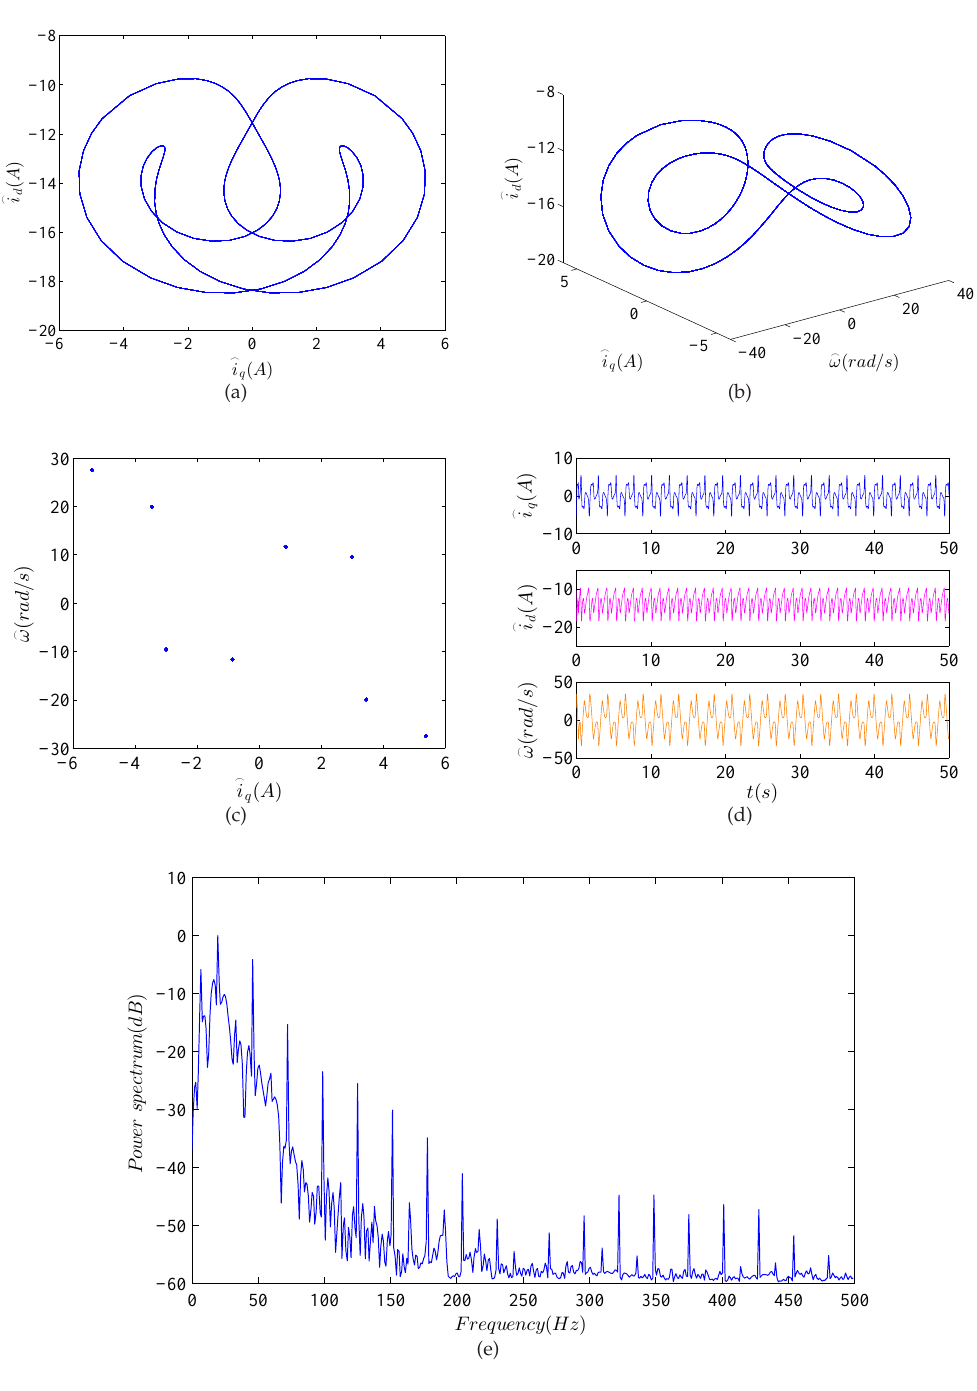
Figure 5. Numerical analysis of nonlinear dynamic behavior with ψ f = 14.2: ( a ) Phase orbit with ⌢ ⌢ i q − i d ; ( b ) Phase orbit with ⌢ ω −